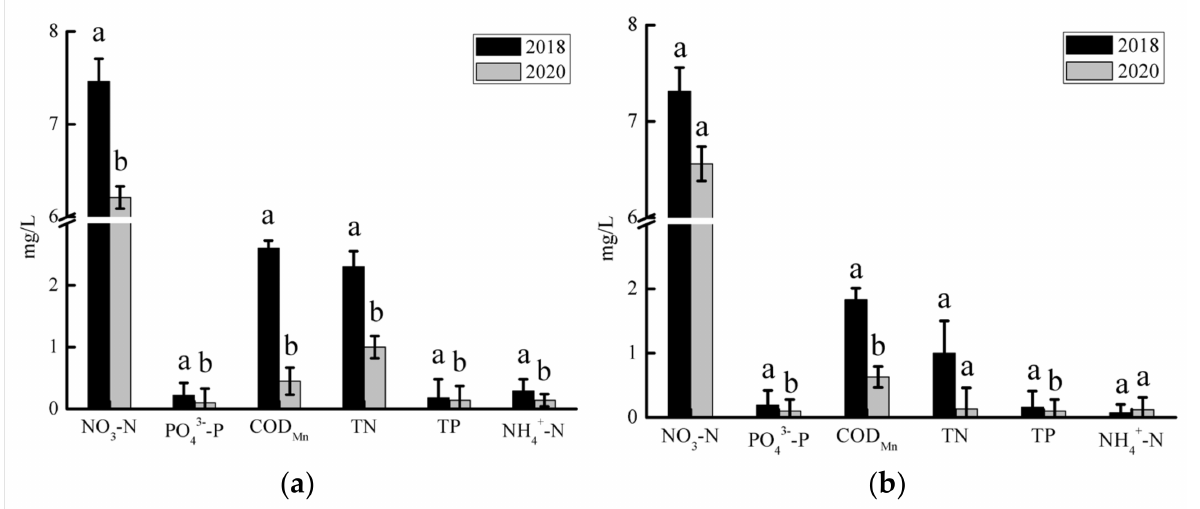
Figure 2. Mean values of different water quality parameters in Shishou ( a ) and Jiayu ( b ) river reaches in different years; the associated bars represent standard deviations. The letters above the error bar represent statistically significant differences in the variables ( p <